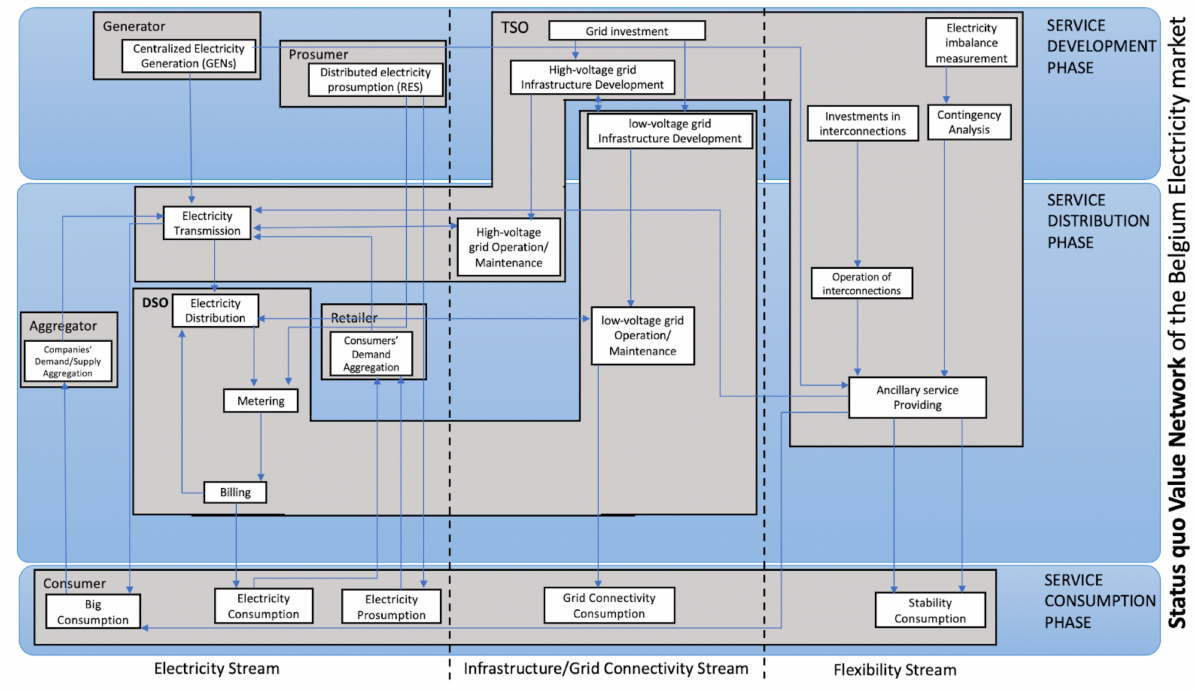
Figure 4. Roles in the current electricity market (note that the diagram represents only roles and actions, not actual physical connections). Reproduced from [10], Institute of Electrical and Electronics Engineers (IEEE): 2020.